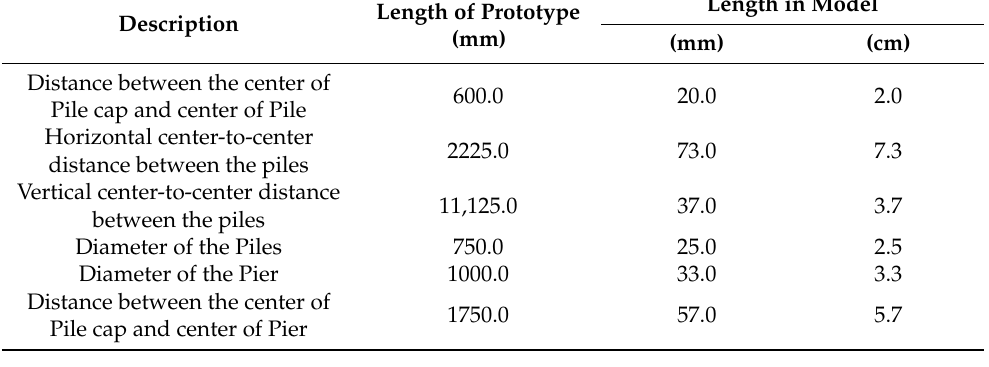
Table 2. Scale down values of different members of bridge pier piles.